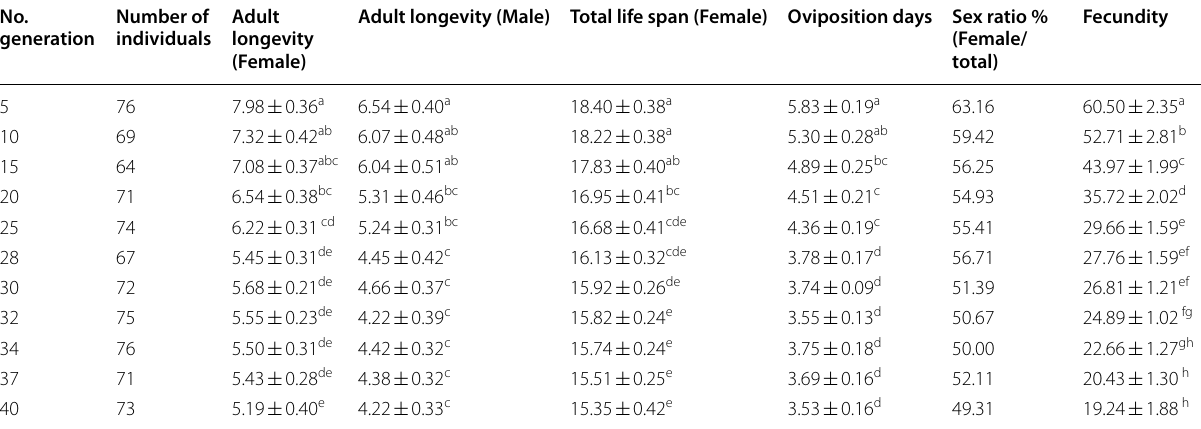
The means marked by the same letters within the same column are not significantly different (Paired-bootstrap test, P < 0.05)